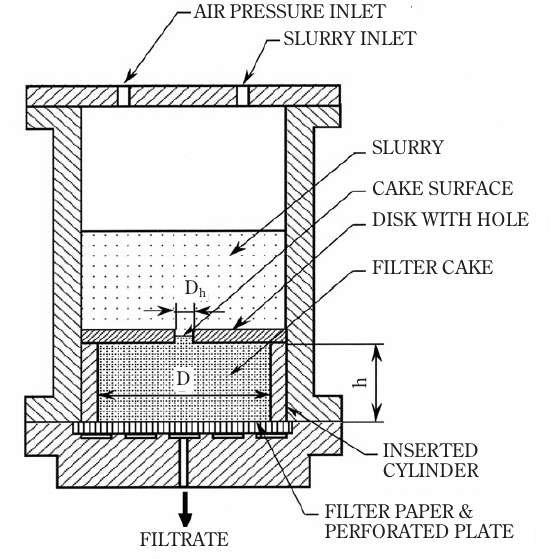
Fig. 1 Schematic diagram of filtration apparatus having sudden reduction in its